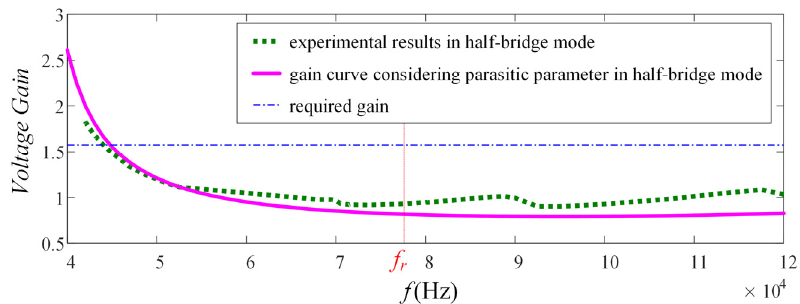
Figure 6. Voltage gain curve of half-bridge LLC.